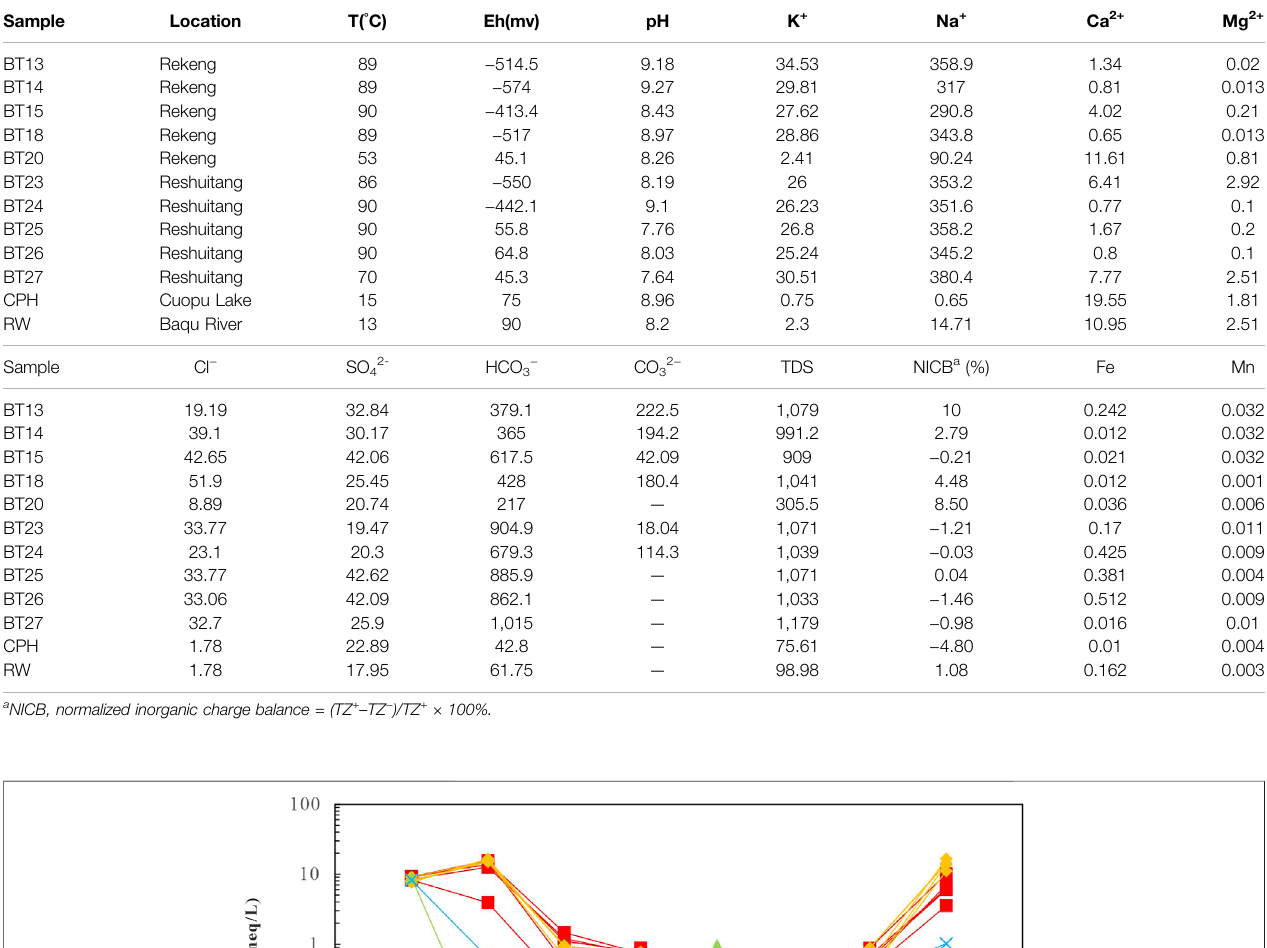
Frontiers in Earth Science |